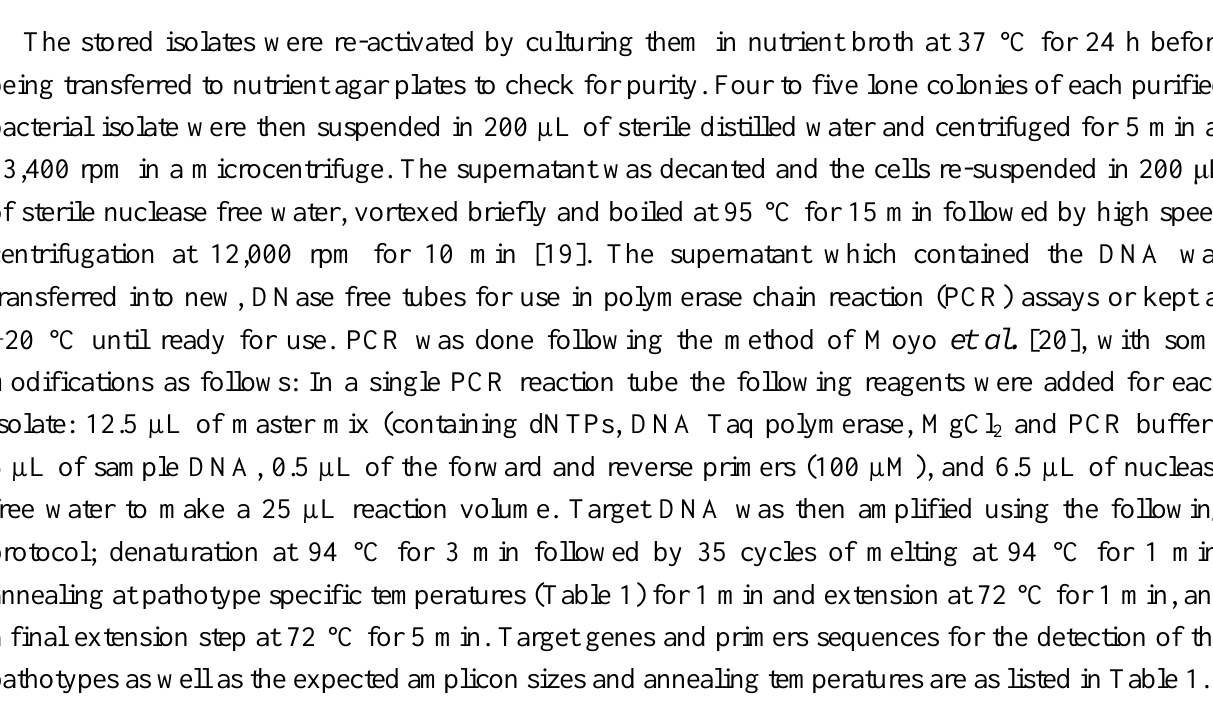
Table 1. E. coli target genes and primer sequences used to identify/characterise E. coli pathotypes.